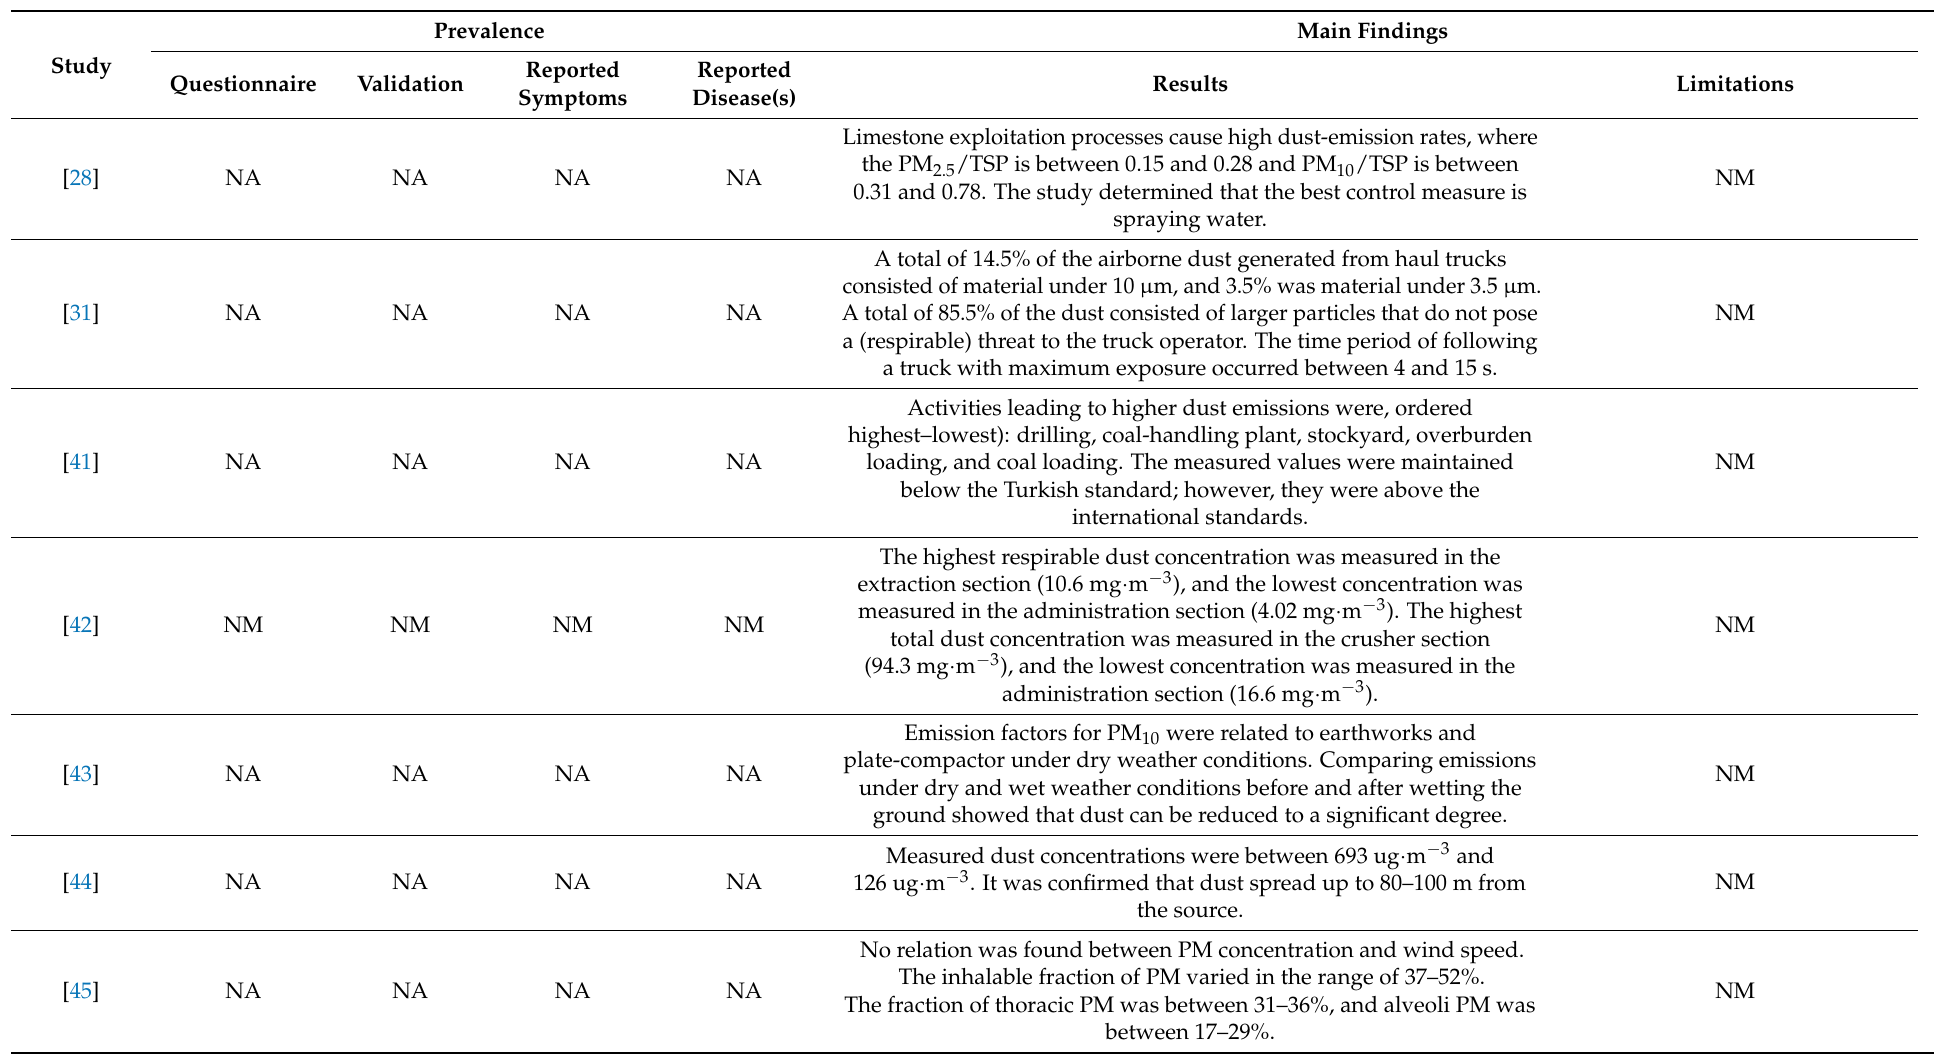
Table A3. Prevalence and main findings per